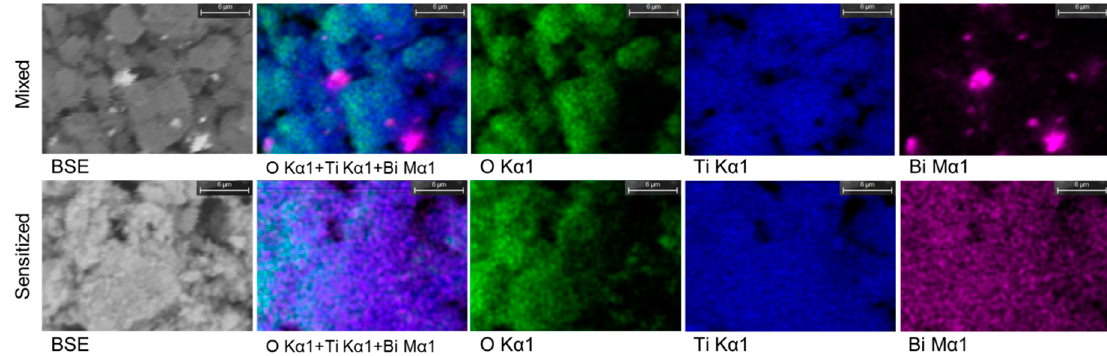
Figure 3. BSE and EDX mapping images of 0.05BiTNT (bottom row) and a simple mixture of TiO 2 and Bi 2 O 3 (top row).